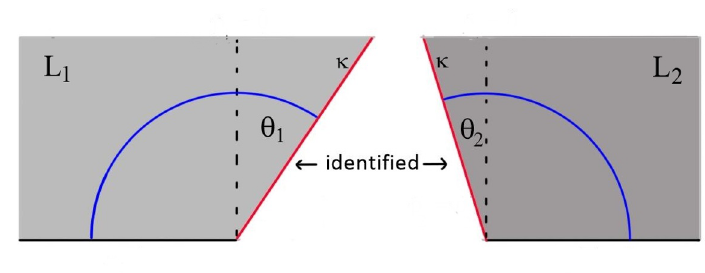
Figure 2. Asymptotic behavior of the domain